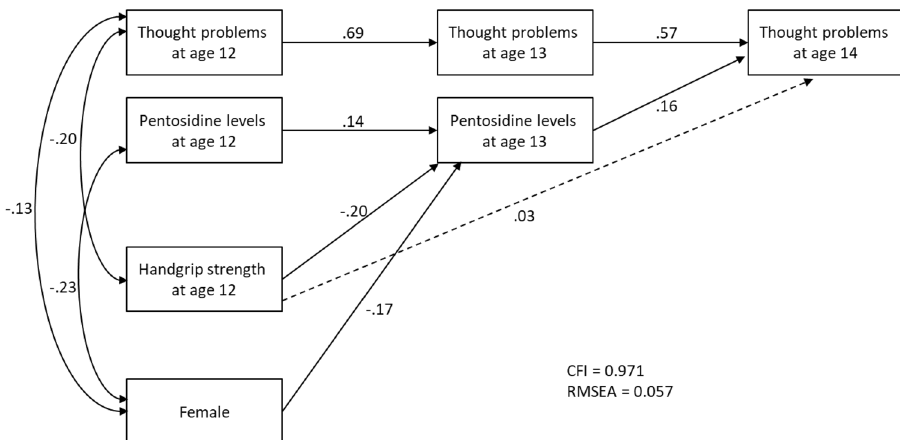
Fig. 2 Path diagram describing the indirect effect between handgrip strength and thought problems via pentosidine. Note: solid black line, path coef fi cient is statistically signi fi cant ( p < 0.05); dotted line, path coef fi cient is not signi fi cant ( p ≥ 0.05). CFI: comparative fi t index, RMSEA: root mean square error of